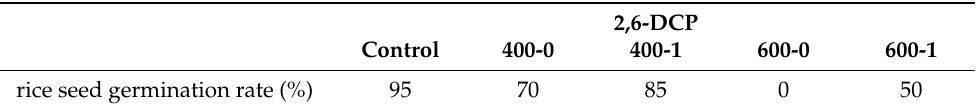
Table 4. Effects of different concentrations of 2,6-DCP on the germination rates of rice seeds before and after degradation by LAC-4